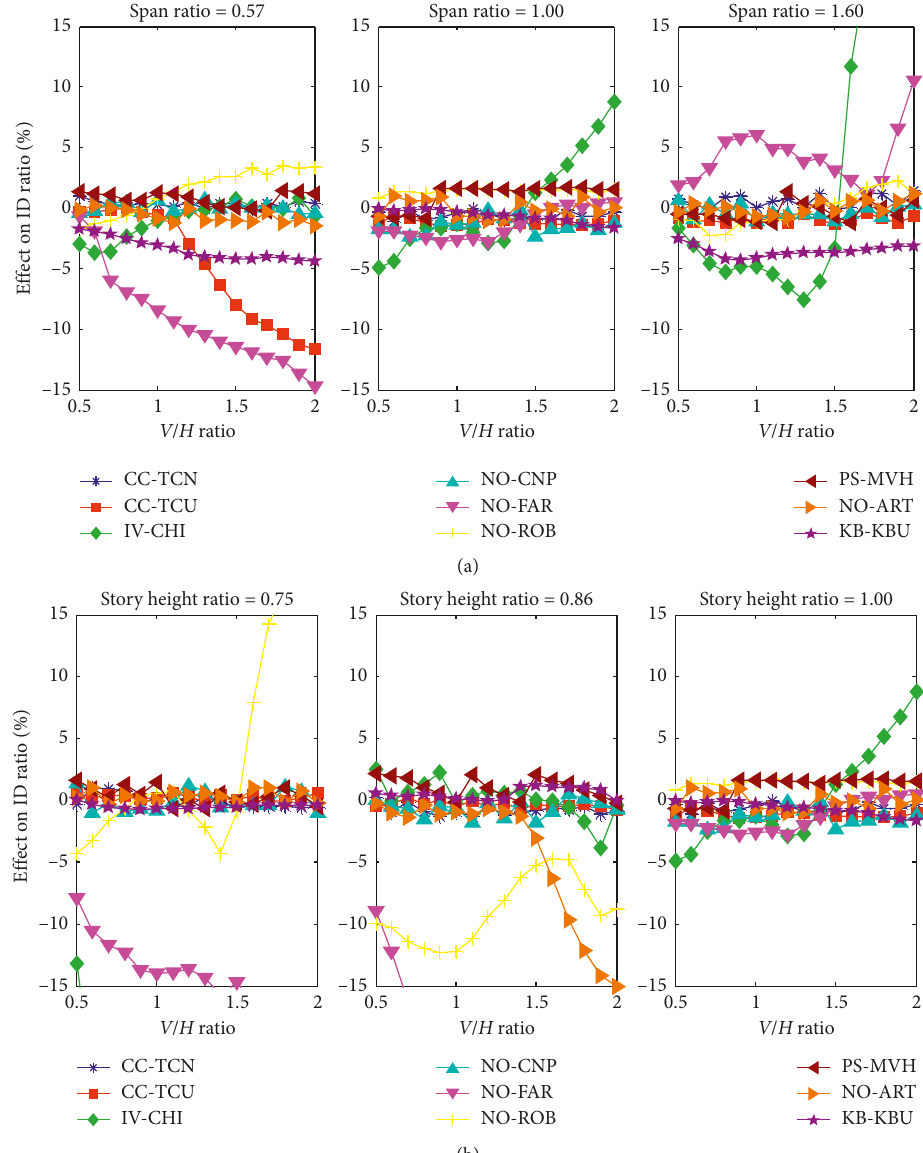
Figure 6: Effect on interstorey drift ratio: (a) span ratio and (b) storey height